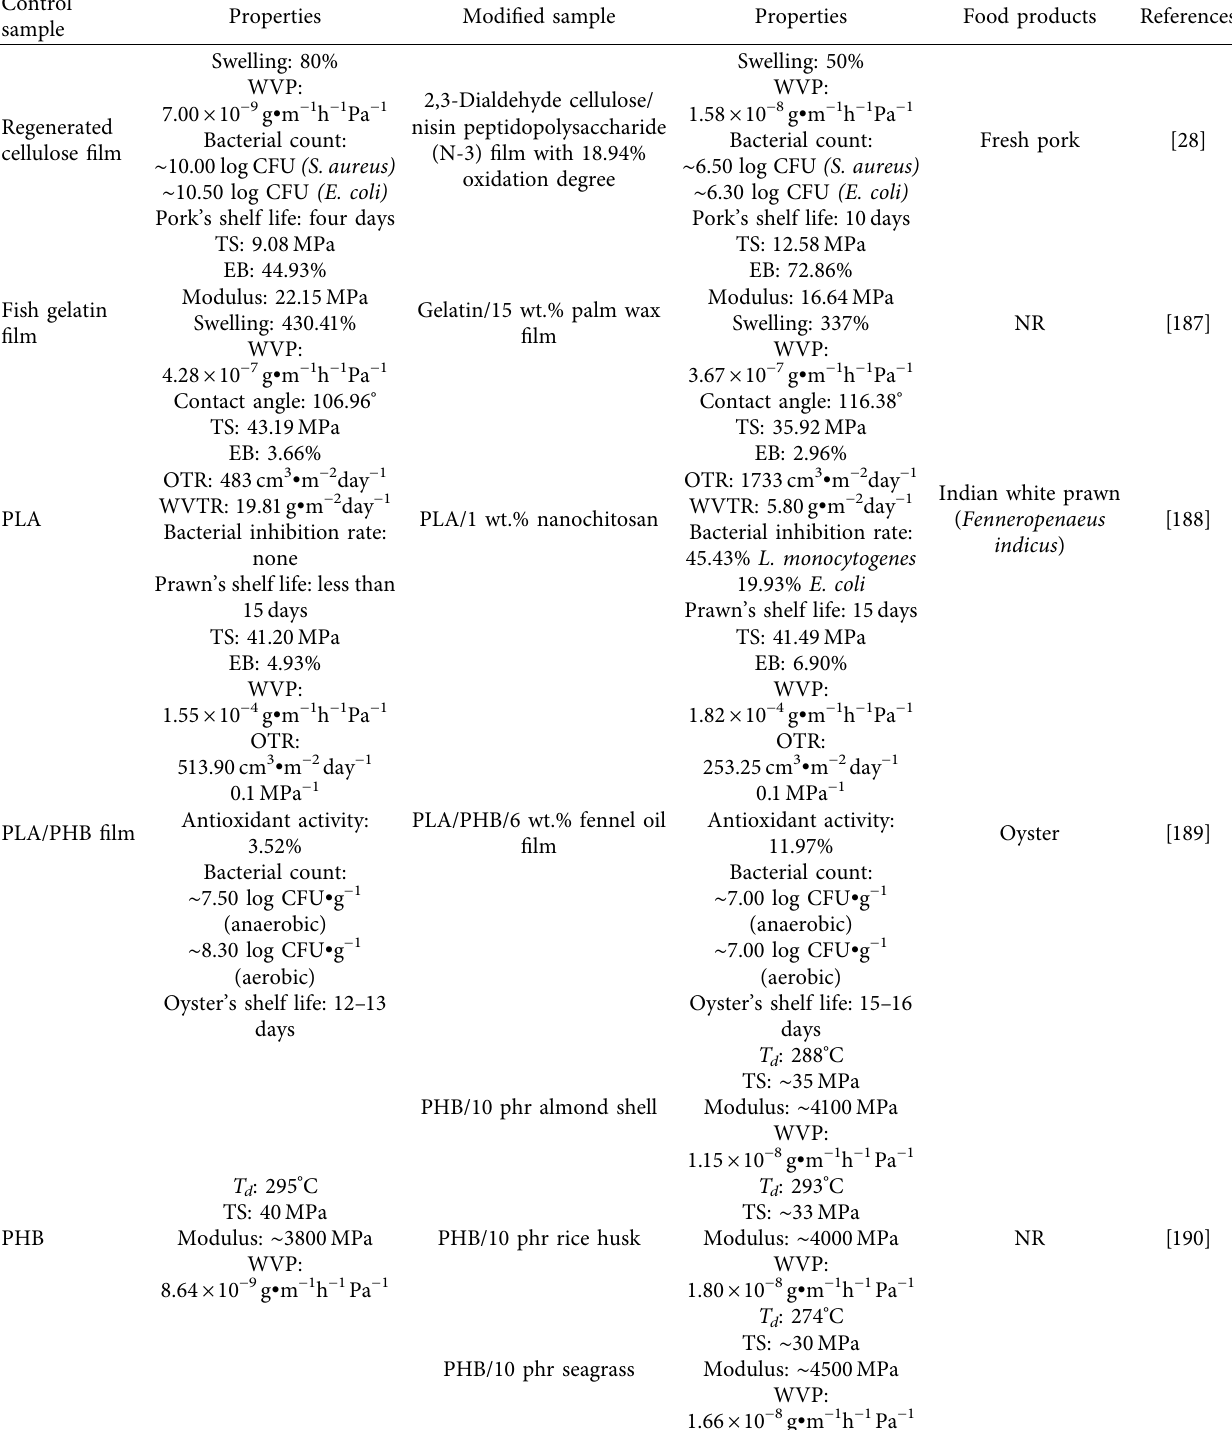
Table 3: Biodegradable composite-based food